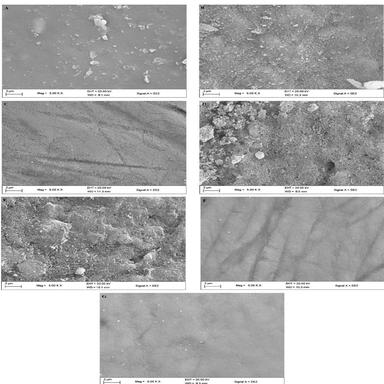
Enamel surface (A) Unexposed tooth; (B) after exposure to HCI; (C) after exposure to Colgate toothpaste; (D) after exposure to Colgate Sensitive; (E) after exposure to Sensodyne (F) after exposure to eggshell; (G) after exposure to TiO2-EB (All exposed samples were in a solution of 0.2 mL HCL for 30 min).